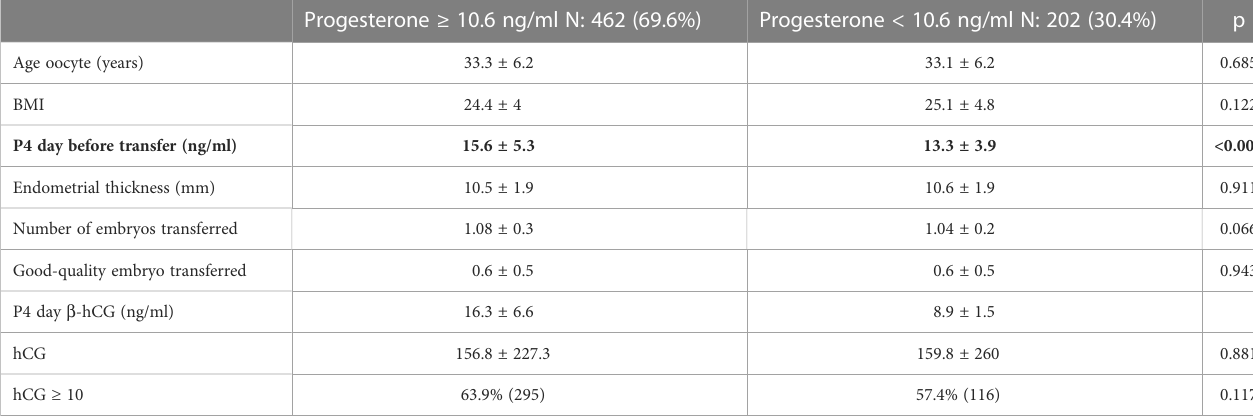
TABLE 1 Baseline characteristics between normal P4 and low P4 on the day of